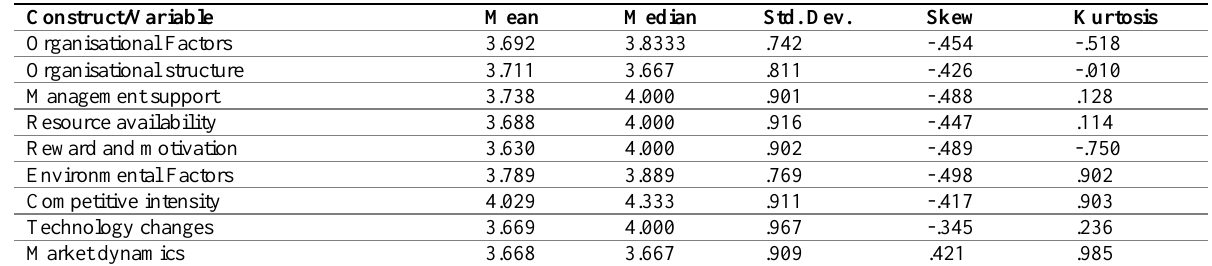
Table 1: Employees Views on the Various Antecedents of Corporate Entrepreneurship among SMEs Construct/Variable